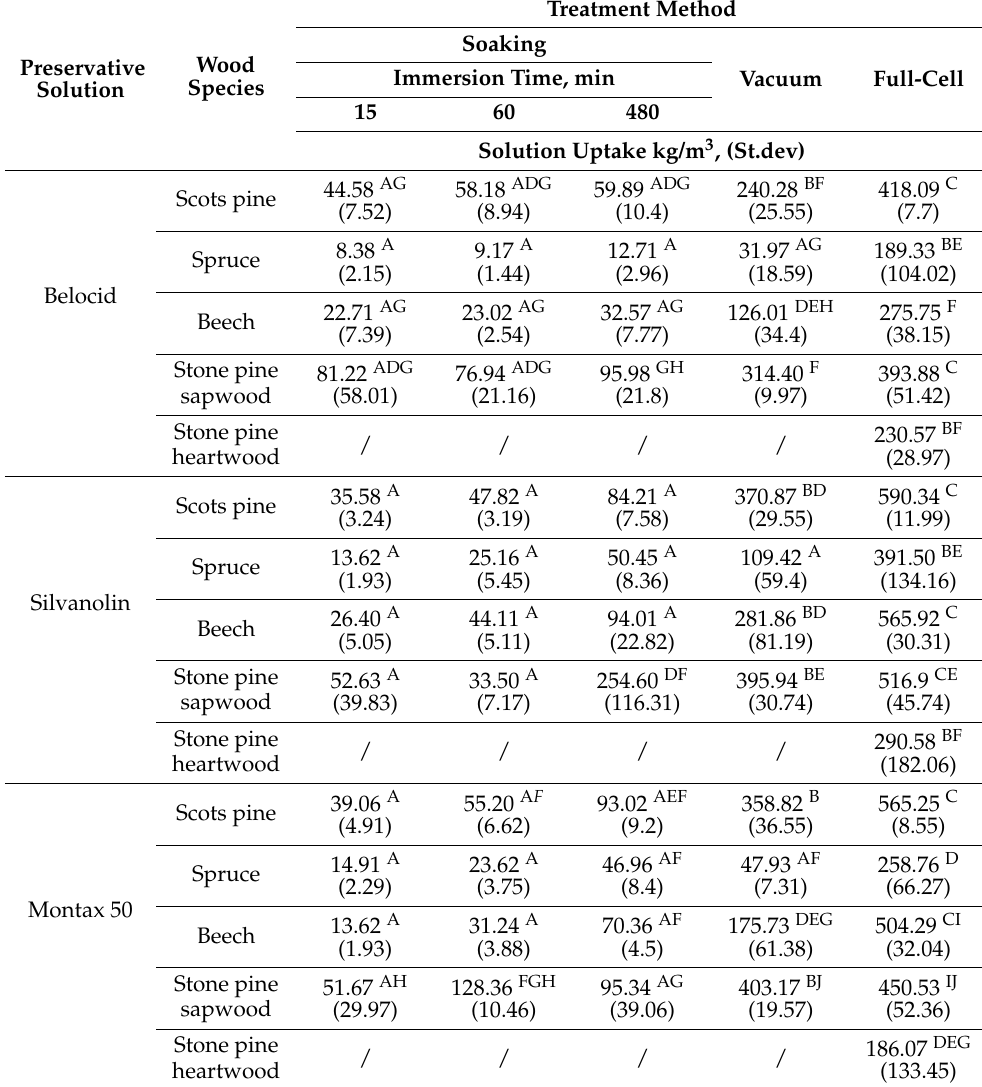
Table 1. Influence of the wood species and impregnation method on the uptake of three preservative solutions and Tukey’s significant difference among the mean uptake values for each of the preservative products utilized. Mean values that share the same upper-case letter are not statistically